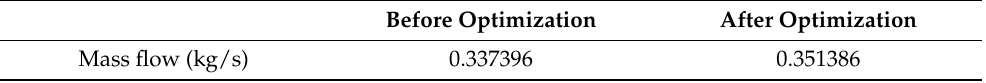
Table 9. Total air mass flow of guide channels before and after optimization. Before Optimization After Optimization Mass flow